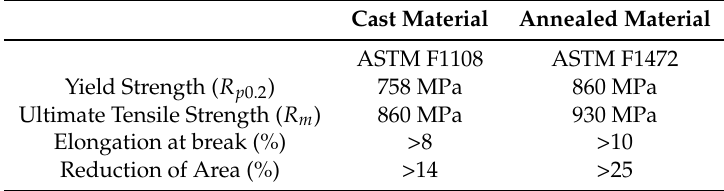
Table 2. Specifications for the mechanical properties for